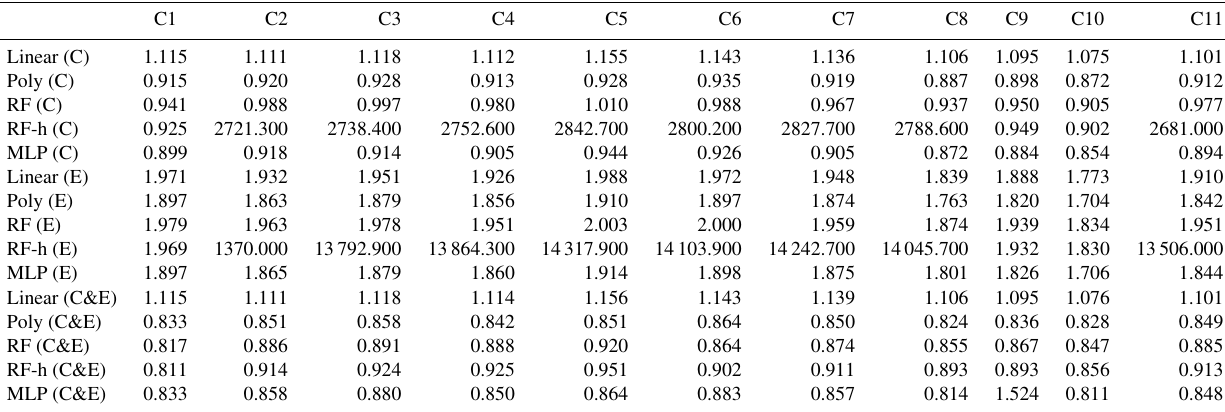
Table A4. RMSE (in ppm) for the different configurations of subsetting based on the selected clusters of peaks. Figaro ® sensors and environmental variables were used to compute this errors. Notation is the same as in Table A3.